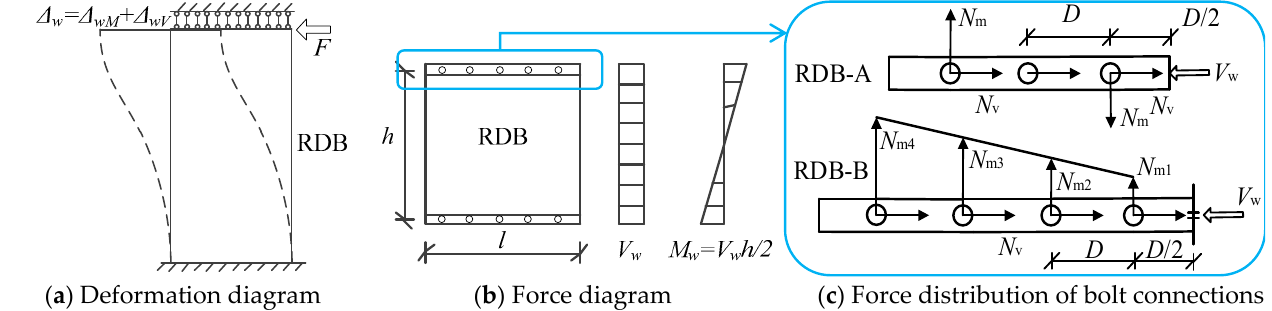
Figure 9. Deformation and force diagrams for RDBs and bolt connections. Table 3. Comparison of elastic stiffness of the theoretical and experimental test results.